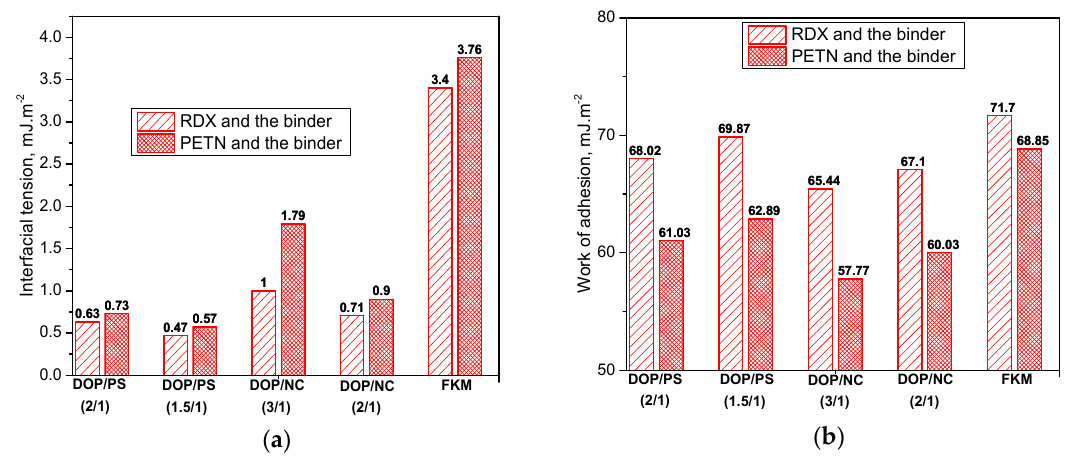
Figure 4. Surface tensions of energetic materials and several binders.